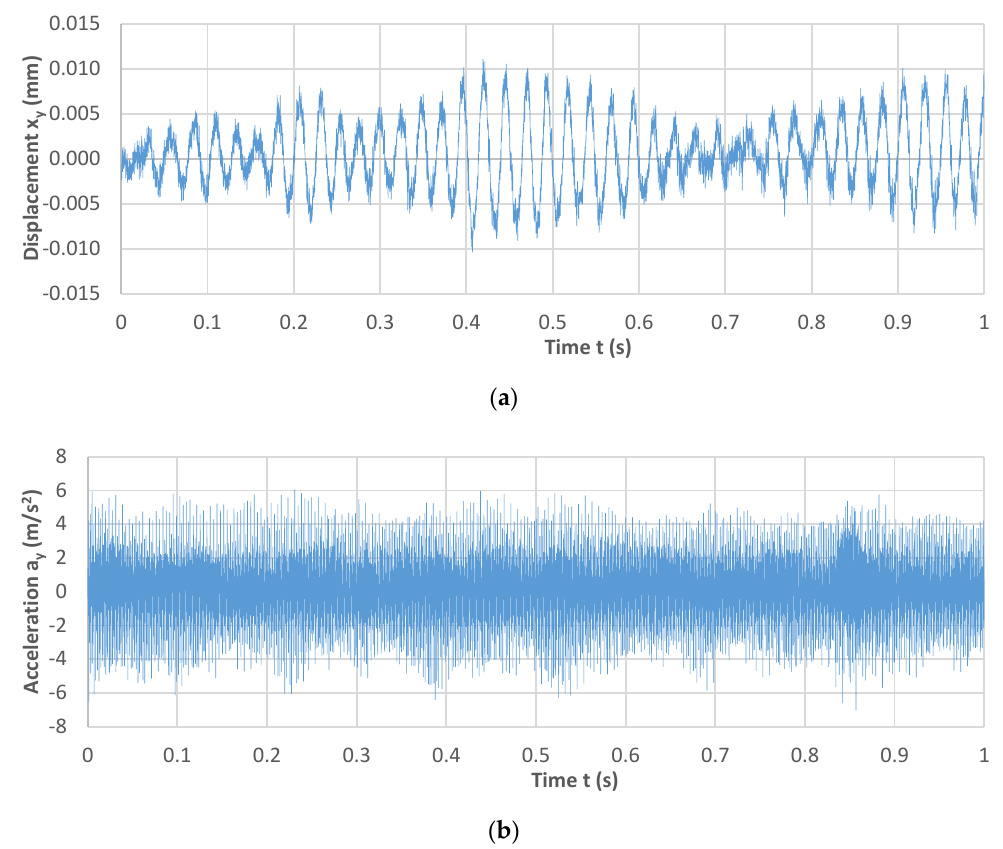
Figure 4. Stability curves for the tool mounted in ER collet chuck, heat shrink chuck, and Tendo E hydraulic chuck (f z = 0.15 mm/tooth).